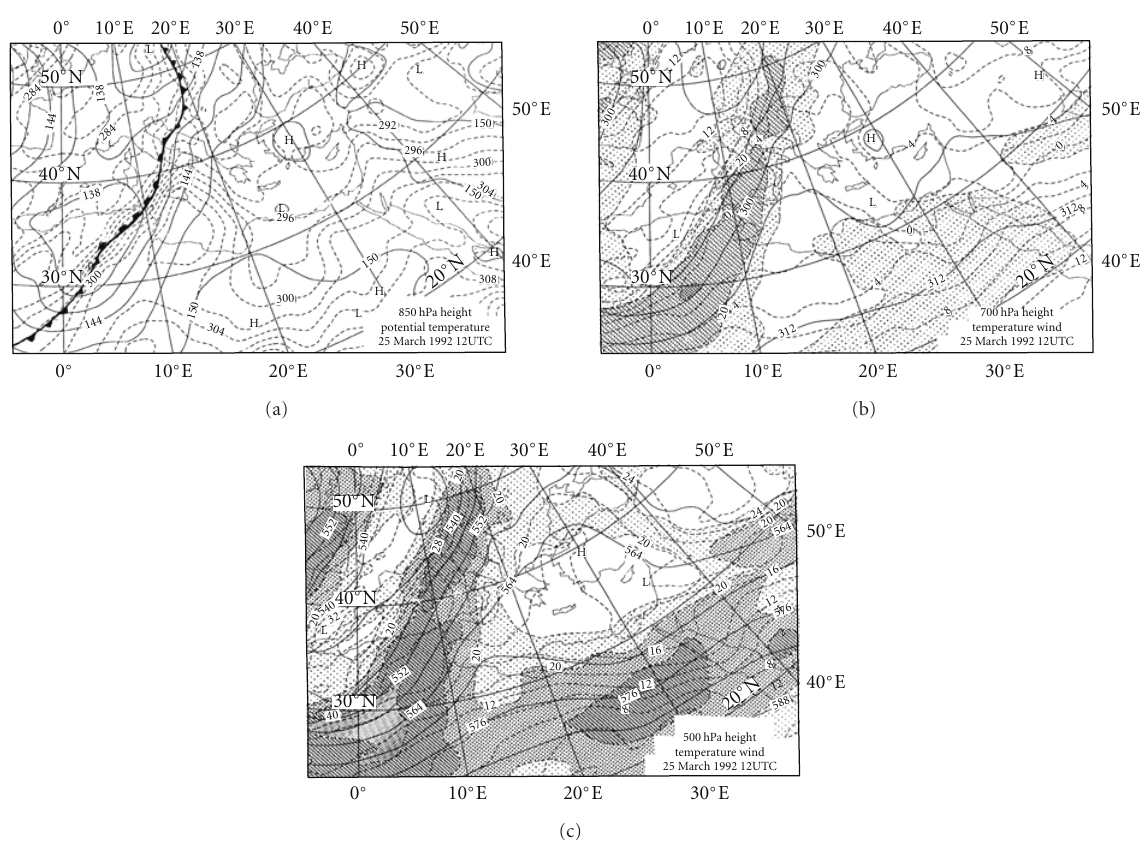
Figure 3: (a) Objective analysis of geopotential height and potential temperature at 850 hpa at 12:00 UTC on 25 March 1992. Geopotential contours: every 30gpm, isentropes: every 2K, (b) 700 hpa and (c) 500 hpa at the same time and date. Contours are drawn every 60 gpm and isotherms every 2 ◦ C. Wind speed above 30 ms − 1 is stippled and more than this is shaded with shading increasing every 5ms − 1 .